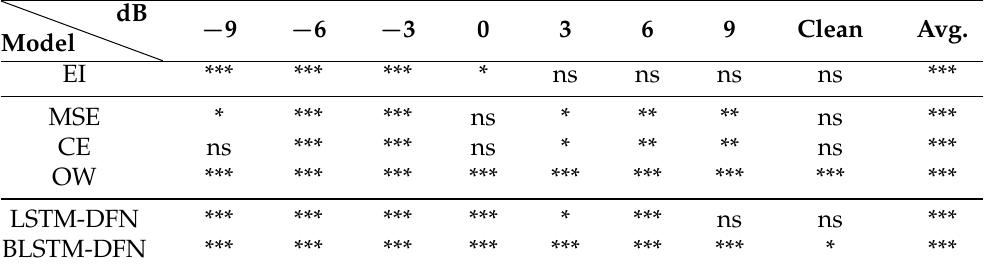
Table 5. Asterisks indicate a statistically significant difference compared with the audio-only model (AO). *** denotes p (cid:54) 0.001, ** shows 0.001 < p (cid:54) 0.01, * corresponds to 0.01 < p (cid:54) 0.05, and ns indicates results where p > 0.05.